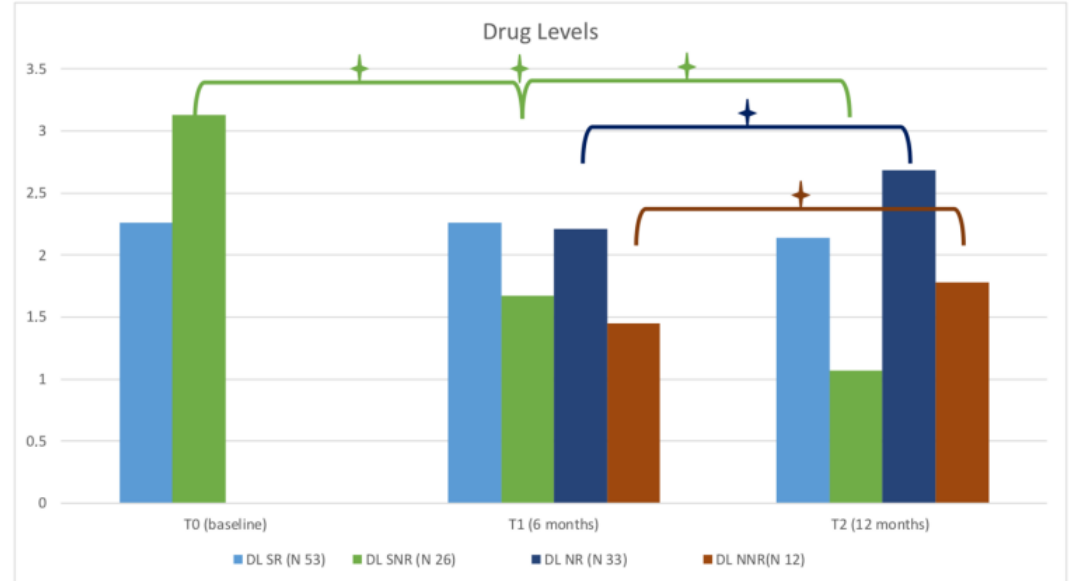
Figure 2. Levels of ETN in naïve patients and switcher responders and non-responders. The plus/star symbol (+) represent p -value = <